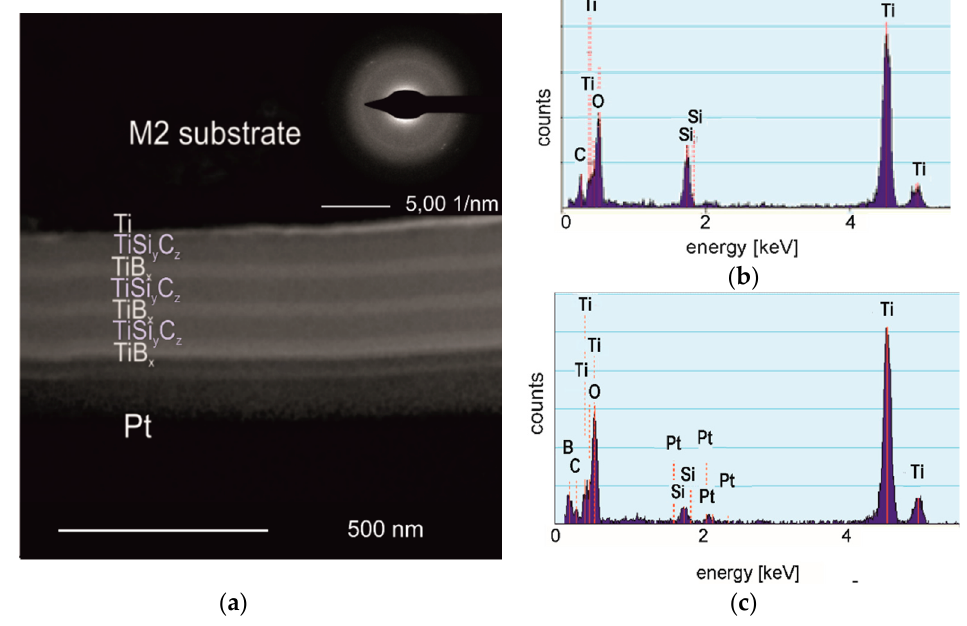
Figure 1. The microstructure of the (TiB x /TiSi y C z )x3 multilayer (cross-section) in as-deposited state. ( a ) TEM bright field image with inserted SAED pattern taken from the coating area; ( b ) EDS spectrum taken from TiSi y C z layer; ( c ) EDS spectrum taken from TiB x layer.